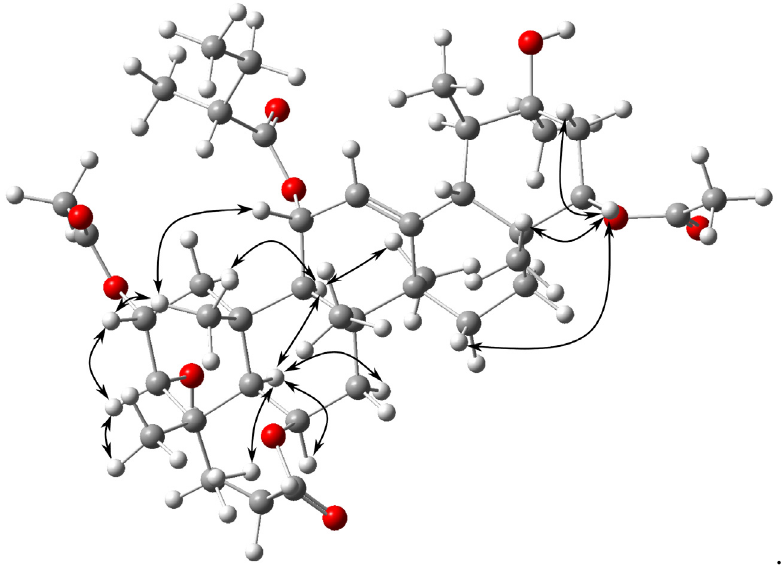
Figure 2. Key NOESY correlations for 1 .